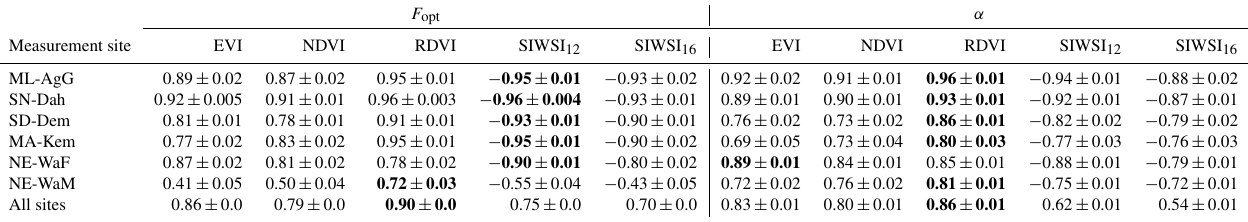
Table 2. Correlation between intra-annual dynamics in photosynthetic capacity ( F opt ; F opt_frac for all sites), quantum efficiency ( α ; α _frac for all sites) and the different vegetation indices for the six measurement sites (Fig. 1). Values are averages ± 1SD generated from 200 bootstrapping runs. The bold values are the indices with the strongest correlation. EVI is the enhanced vegetation index, NDVI is the normalized difference vegetation index, RDVI is the renormalized difference vegetation index and SIWSI is the shortwave infrared water stress index. SIWSI 12 is based on the MODIS NBAR bands 2 and 5, whereas SIWSI 16 is based on MODIS NBAR bands 2 and 6.